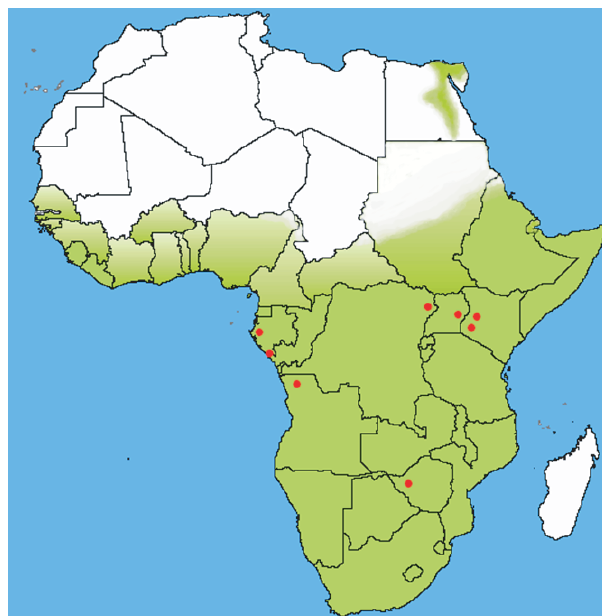
Figure 4. Geographic distribution (green shade) of Rousettus aegyptiacusin Africa. Red dots indicate the locations of all previous known Marburg virus outbreaks, as indicated in Figure 1, in addition to the locations of the Marburg-positive